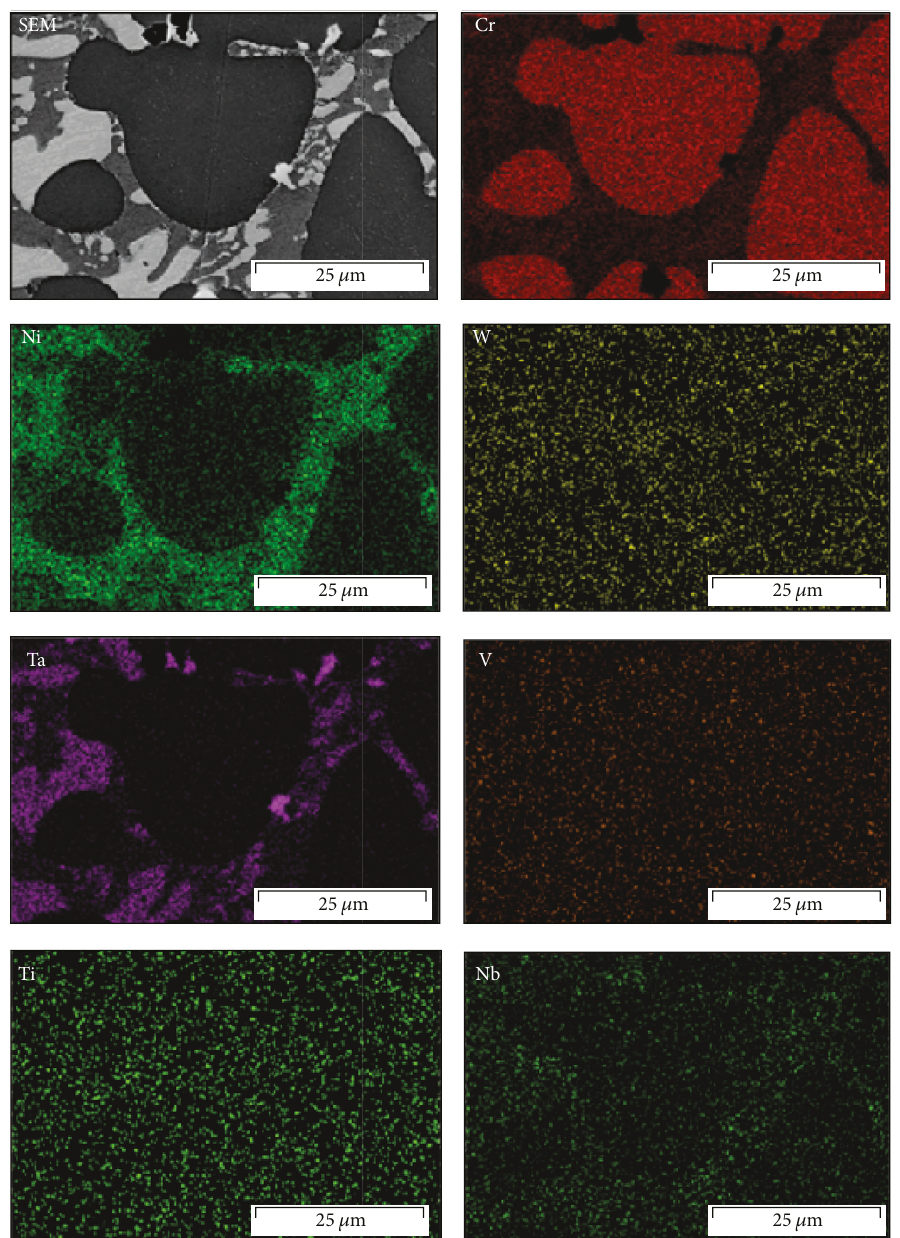
Figure 5: Scanning electron micrograph (SEM, not etched sample) and electron probe microanalysis maps of the (Ta, Nb)-bearing alloy after melting, electric slag remelting, and annealing.